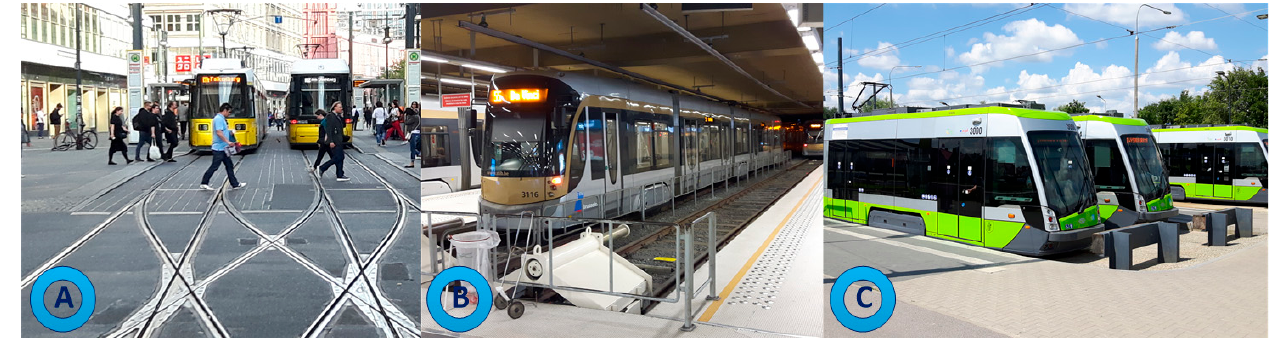
Figure 4. Examples of tram route terminals without applying tram loops: ( A ) Alexanderplatz, Berlin, Germany; ( B ) Rogier, Brussels, Belgium; ( C ) Kanta, Olsztyn, Poland (own study). In case there is no space for placing two tracks and a terminus at the switch-back terminal, it is possible to place a single track intended only for turning around and locate the tram stops before the switch-back terminal. An example of such an application is shown in Figure 5.